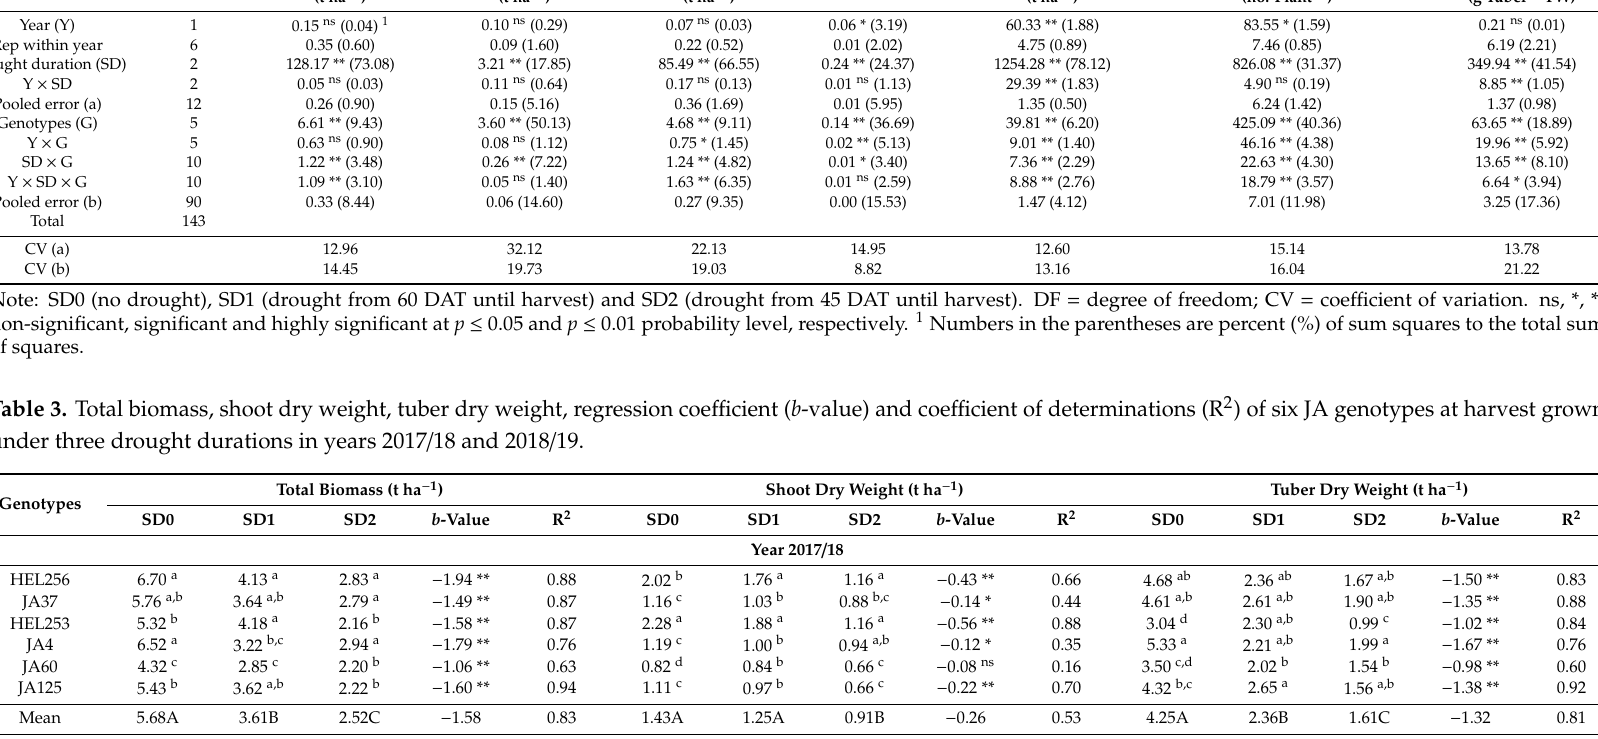
Table 2. Combined analysis of variance of total biomass, shoot dry weight, tuber dry weight, harvest index, tuber fresh weight, number of tubers per plant and fresh weight per tuber of six JA genotypes at harvest grown under three drought durations in years 2017 / 18 and 2018 / 19. Source of Variance